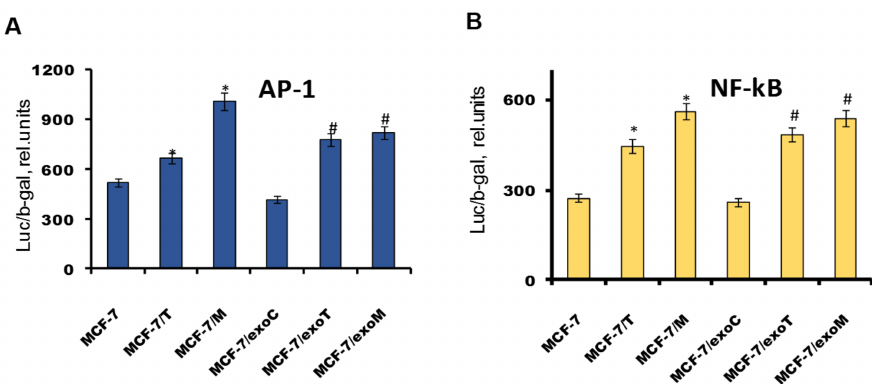
Figure 8. Transcriptional activity of AP-1 and NF-κB. The cell lines were similar to that in Figure 5. Transcriptional activity of AP-1 ( A ) and NF-κB ( B ) was determined by reporter assay. The cells were transfected with the AP-1 or NF-κB plasmid containing the luciferase reporter gene under the AP-1 or NF-κB-responsive elements, and β-galactosidase plasmid. 24 h after transfection the luciferase and β-galactosidase activities were determined as described above. Data represent mean value ± S.D. of three independent experiments. * p < 0.05 versus MCF-7, # p < 0.05 versus MCF-7/exoC.